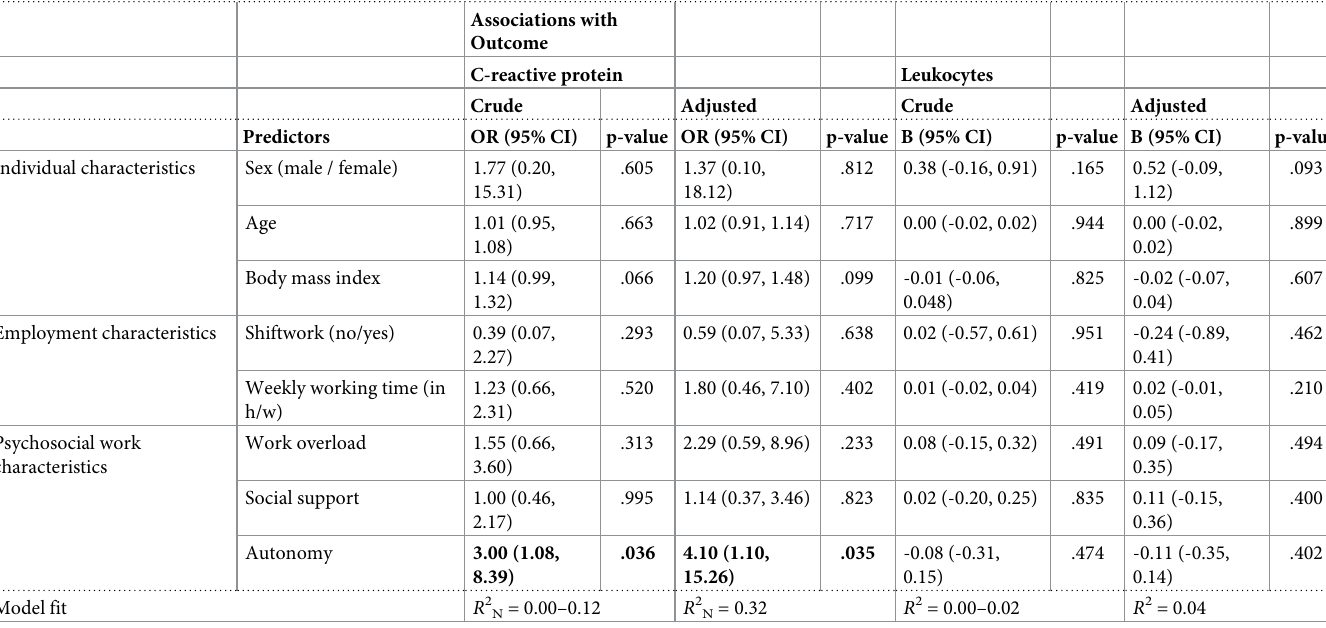
Table 2. Crude and adjusted associations of care professionals’ individual, employment, and psychosocial work characteristics with inflammatory markers (C-reac- tive protein and